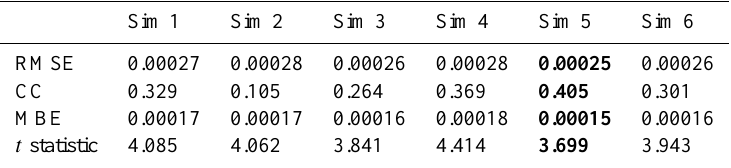
Table 5. Statistical evaluation of different simulations for precipitation rate.